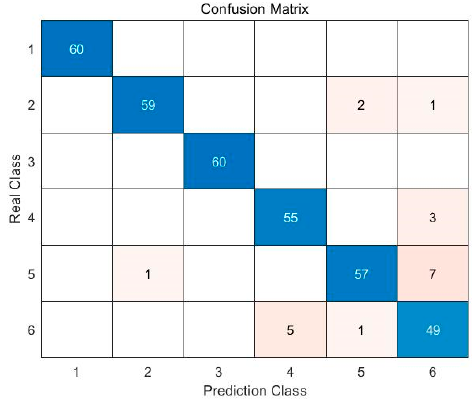
Figure 15. Confusion Matrix.